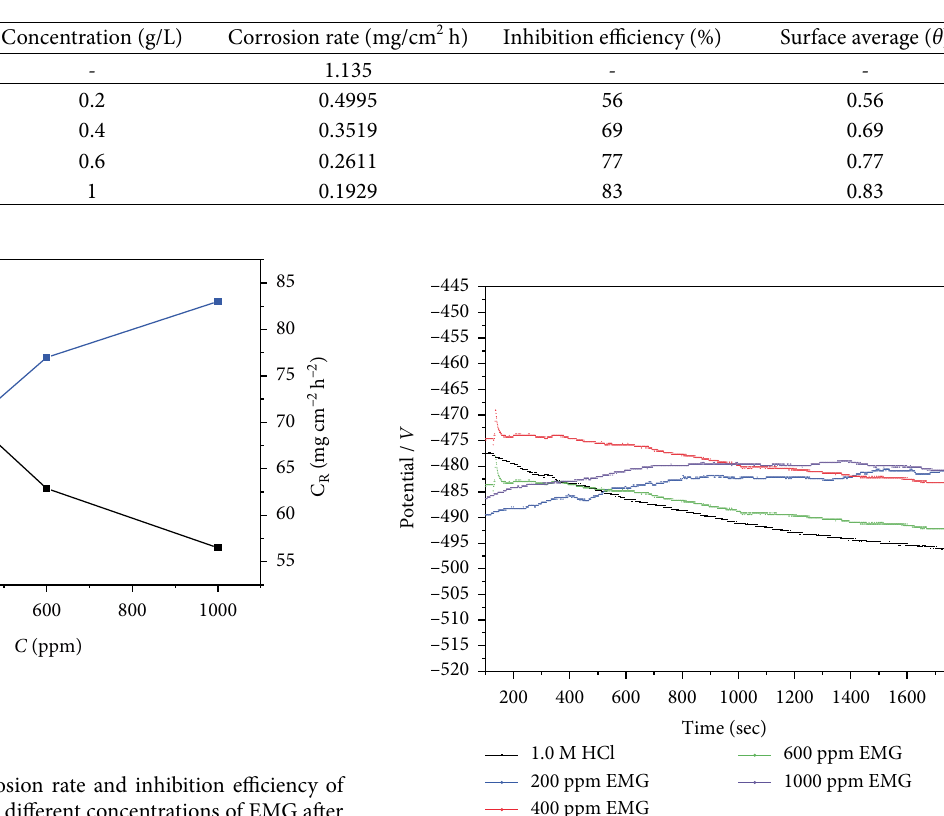
Figure 4: OCP of mild steel electrode in 1.0 M HCl at 303 K without and with different concentrations of inhibitors.